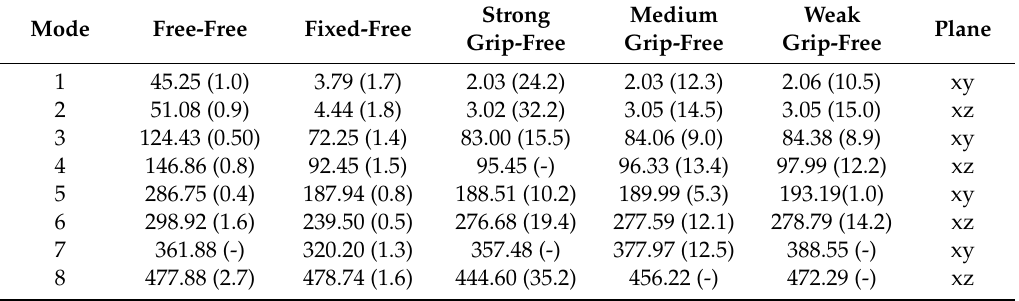
Table 3. Identification of modal data. The deformed shapes correspond to bending. The results are expressed in Frequency-Hz (Damping-%). (-) corresponds to an undefined value.